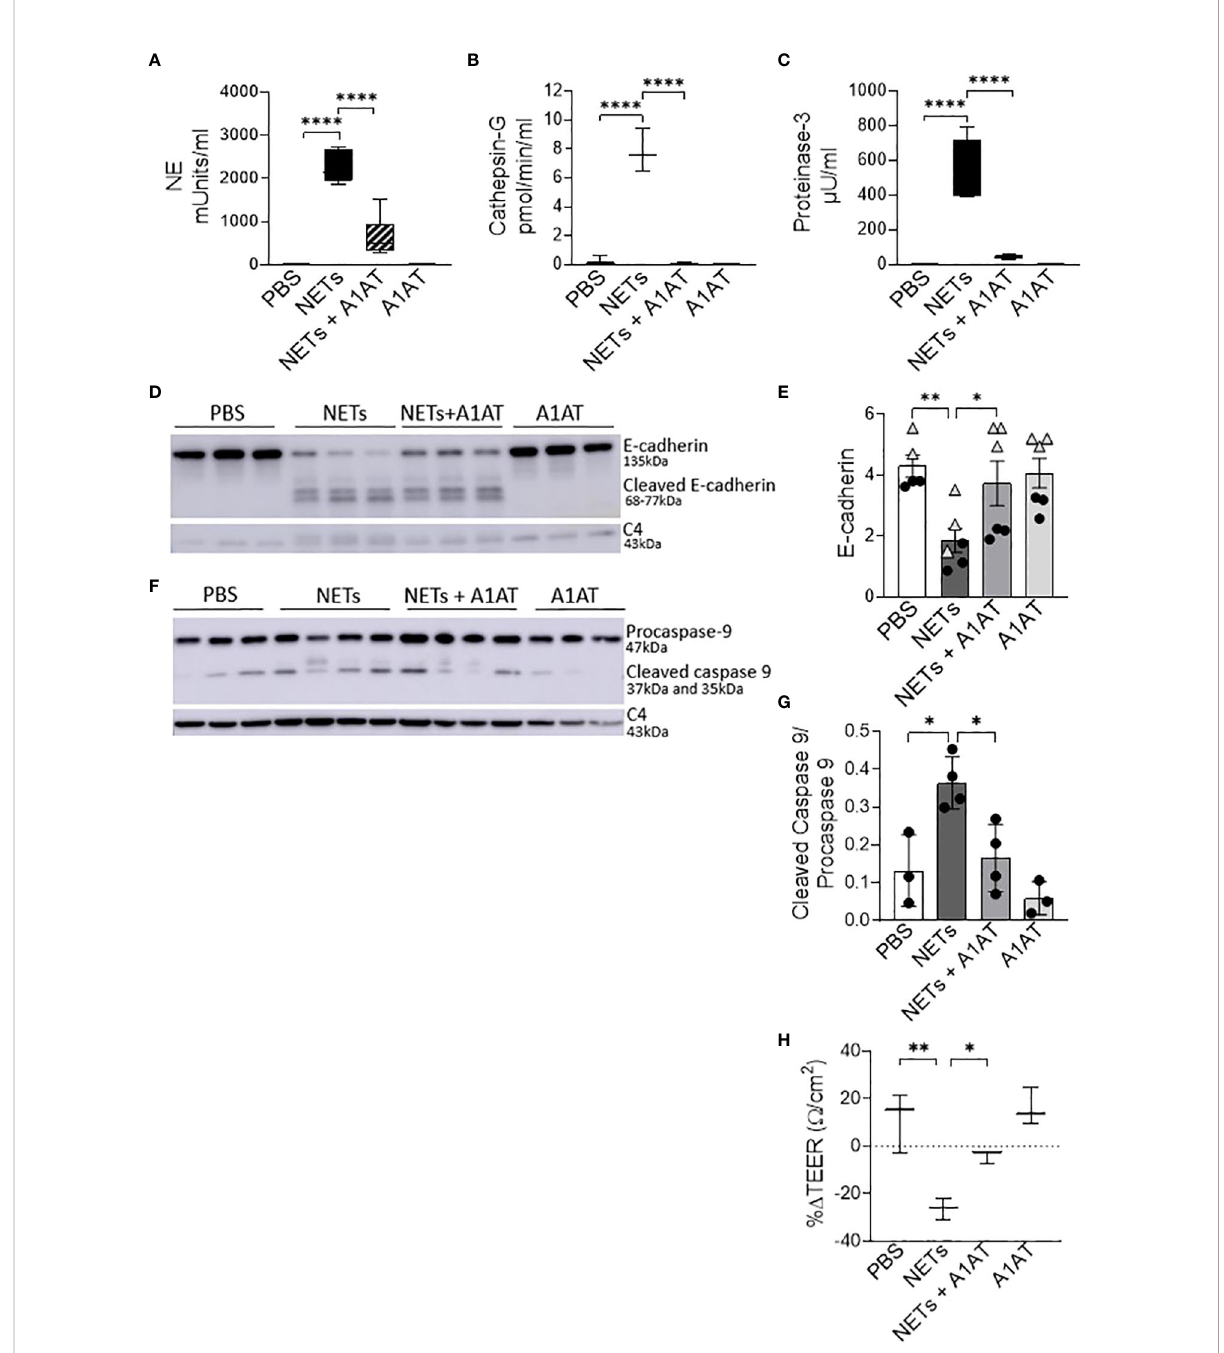
FIGURE 5 Alpha-1 antitrypsin reduces NET-driven barrier dysfunction. HBE were exposed to PBS, 5µg/ml NETs, NETs+A1AT or A1AT for 18h in triplicate wells. (A – C) Activity of neutrophil elastase (NE), cathepsin G (CG), and proteinase 3 (PR3) were reduced in the apical supernatants of HBE exposed to NETs+A1AT. Data analyzed by one-way ANOVA followed by Bonferroni ’ s multiple comparisons test (experiments=3, HBE donors=4, NET donor=2). (D, E) Representative western blot and analysis of E-cadherin protein from lysates of HBE demonstrates that NETs decrease full- length E-cadherin and increases cleaved E-cadherin peptides compared to PBS control. A1AT limits NET-driven reductions in full-length E- cadherin protein. (F, G) Representative western blot and analysis demonstrate decreased cleaved caspase 9 (less activation of apoptosis) in HBE exposed to NETs with A1AT. Western blots were normalized to C4-actin and analyzed by one-way ANOVA followed by Bonferroni ’ s multiple comparisons test (experiments=2, HBE donors=2, NET donors=3). (H) A1AT maintained HBE TEER with exposure to NETs (representative graph). Data analyzed by one-way ANOVA followed by Bonferroni ’ s multiple comparisons test (experiments=3, HBE donors=3, NETs=3). *p < 0.05, **p < 0.01, ****p <